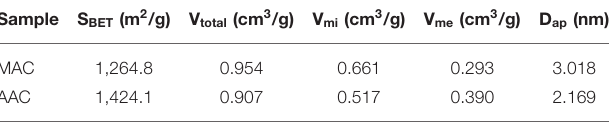
TABLE 1 | Textural properties of MAC and AAC obtained from BET, HK, and BJH model*.